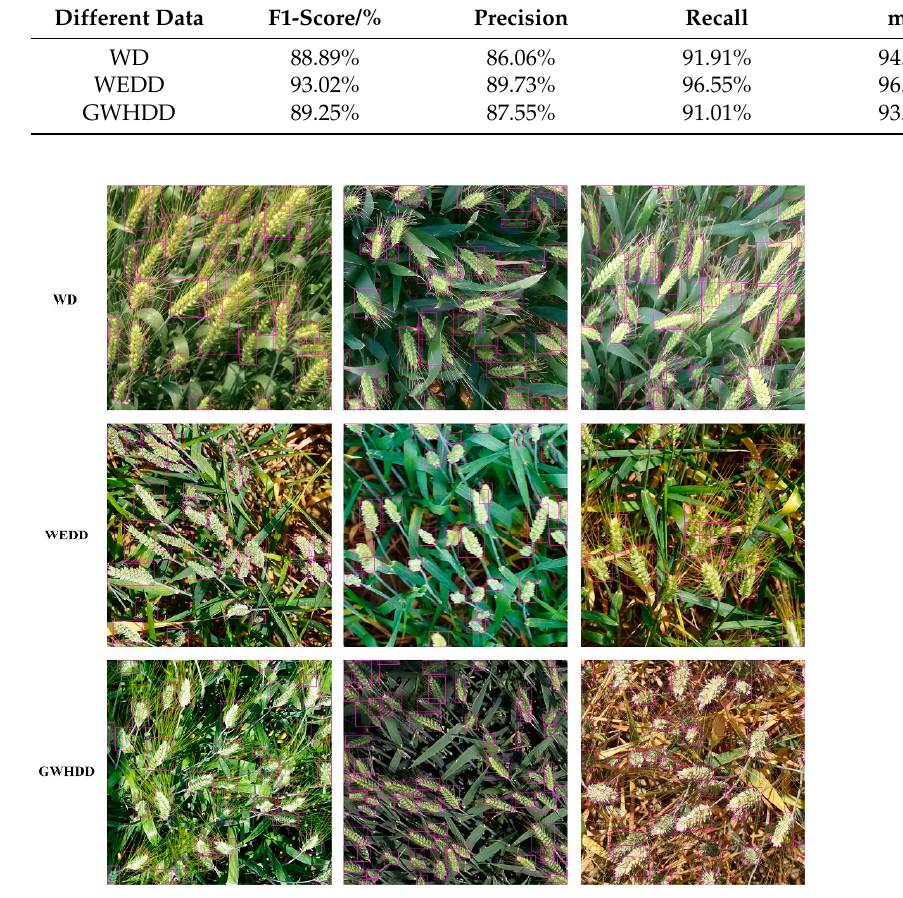
Figure 7. Examples of wheat ear detection results of different data sets.